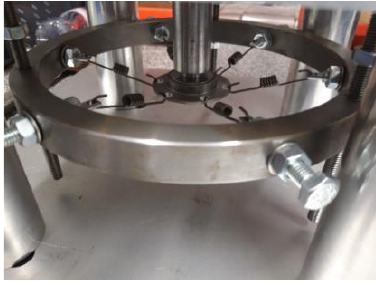
Figure 4. Bearing balanced by flexible six-spring set.